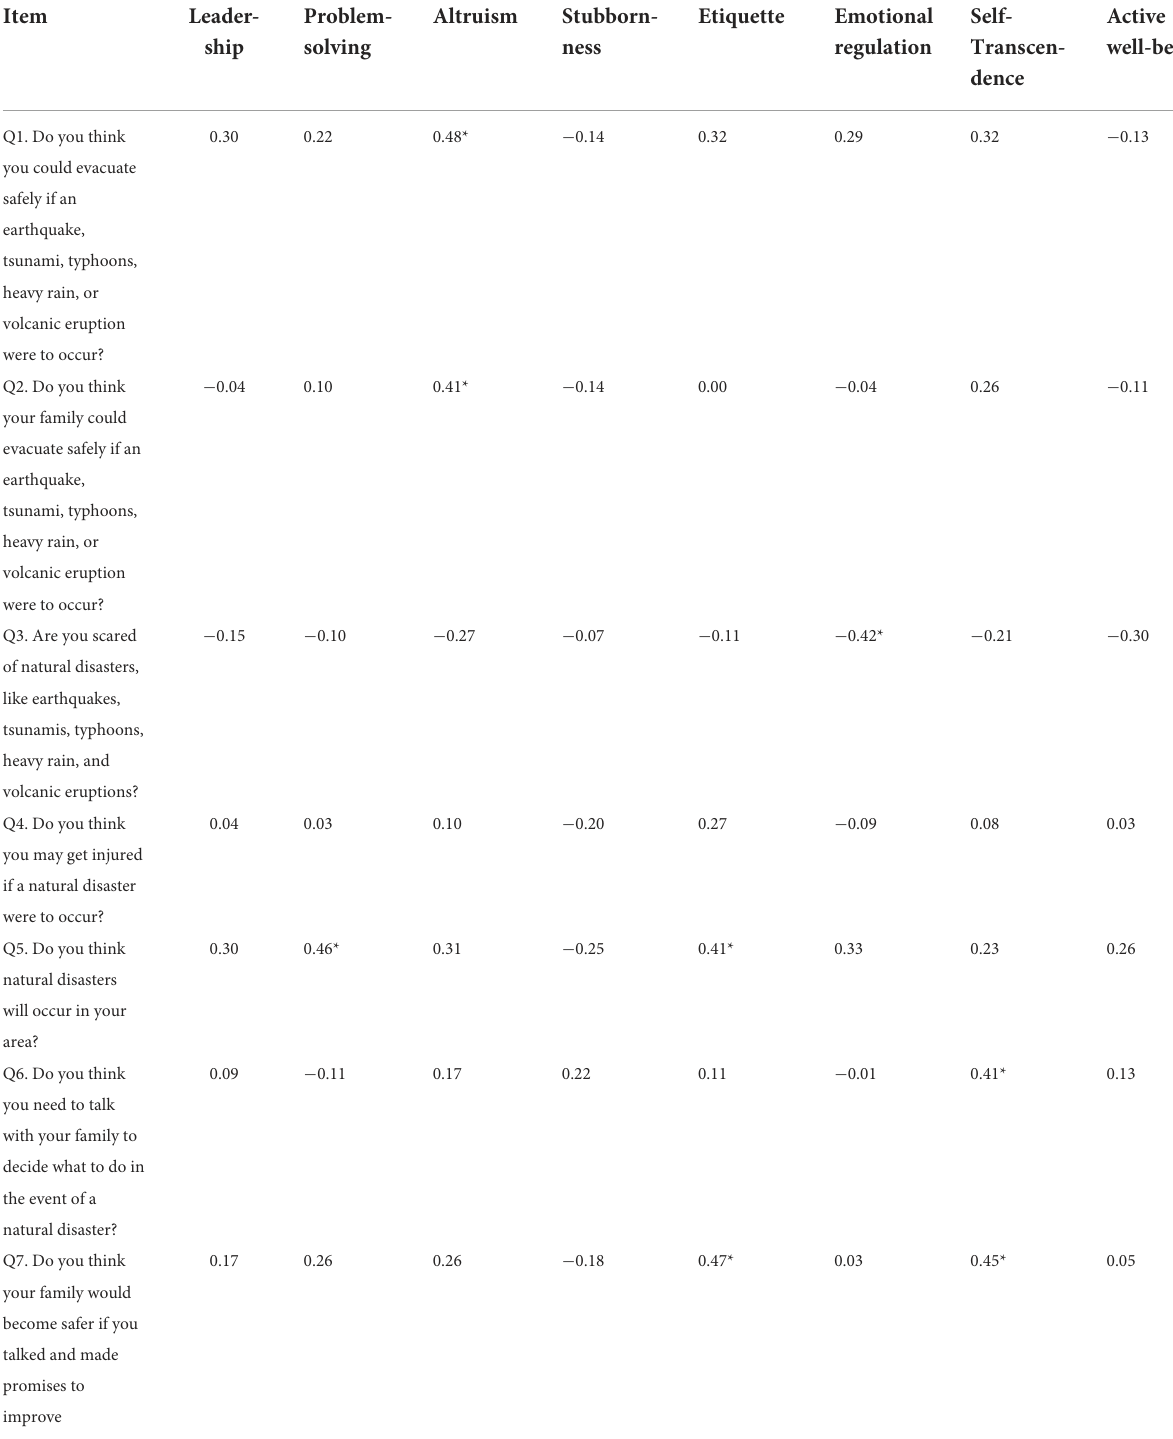
TABLE 2 Correlation coefficients between disaster prevention awareness and power to live factors (34-item version). Item Leader-